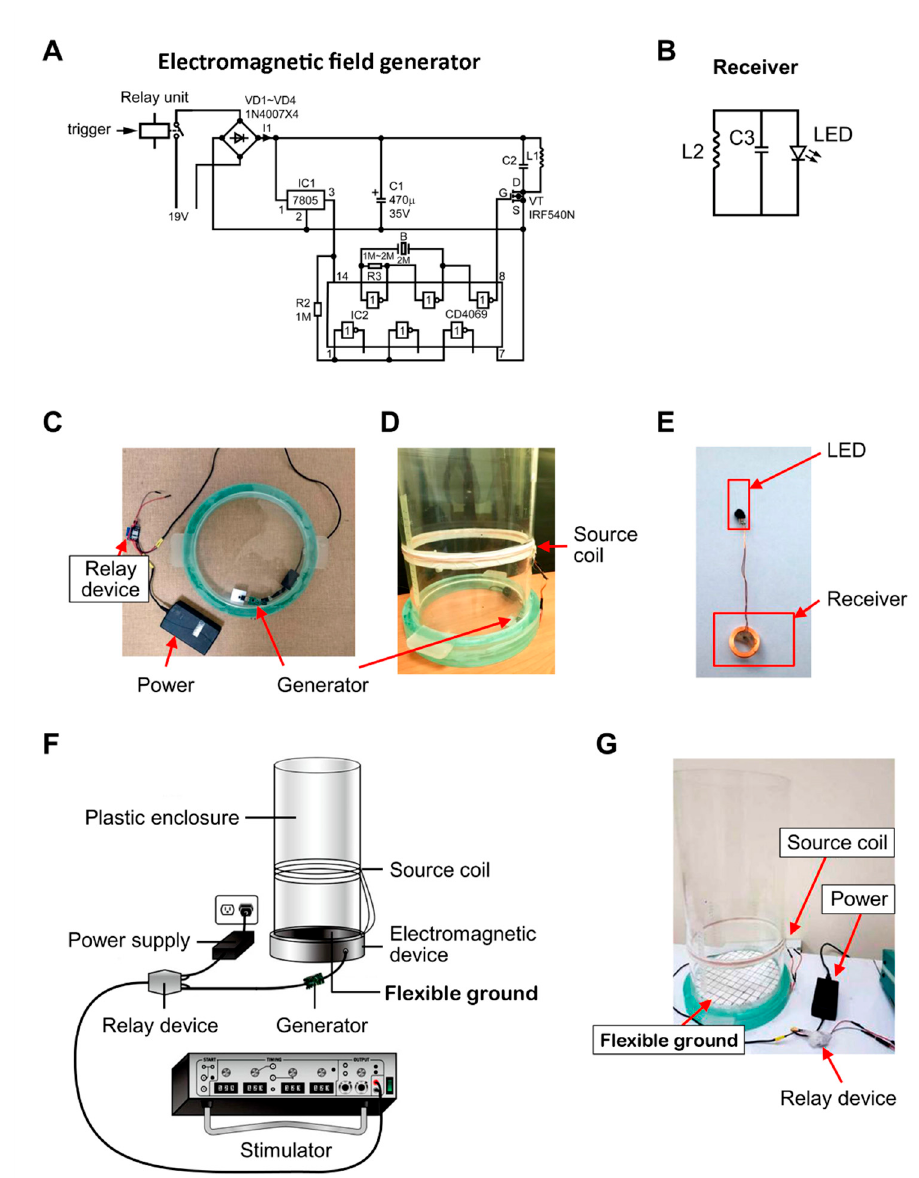
Figure 1. Description of the wireless remote-controlled device components. ( A ) The diagram of the electromagnetic field driving circuit. ( B ) The receiver circuit. ( C ) The power supply, relay device, and generator. ( D ) The source coil, generator, and plastic enclosure. ( E ) The receiver and the light-emitting diode (LED). ( F ) All the crucial components: plastic enclosure, electromagnetic device with a coil, flexible ground, power, relay device, stimulator, and a receiver associated with an LED light. ( G ) The electromagnetic field generator under the ground of the plastic enclosure.